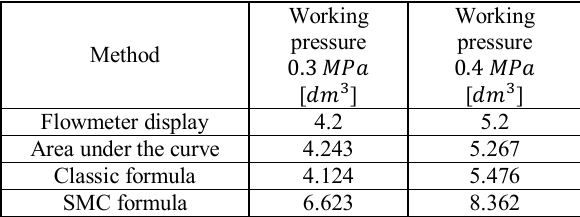
Tab. 3. Comparison of each method to determine consumption of compressed air for measurement with interruption of air